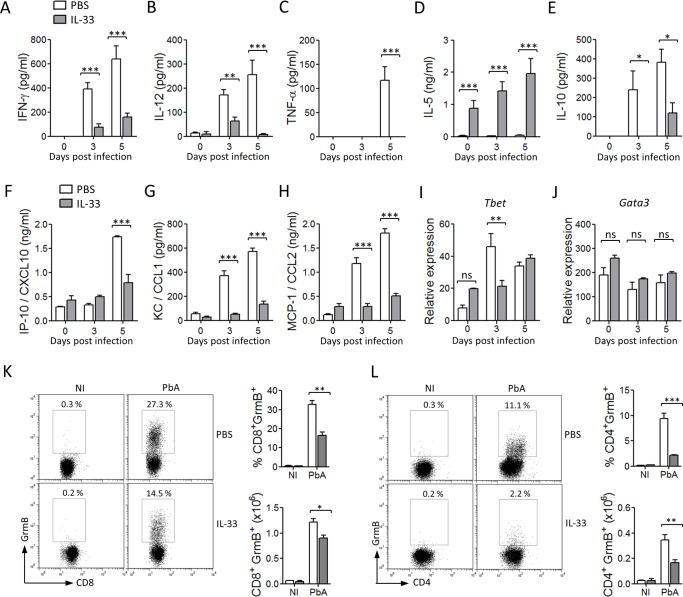
IL-33 reduces pro-inflammatory cytokines and chemokines in PbA-infected mice.C57BL/6 mice were not infected (NI) or infected with PbA and injected i.p. daily with PBS (open columns) or IL-33 (filled columns) from day 0 for 5 consecutive days. (A-H) Serum IFN-γ, IL-12, TNF-α, IL-5, IL-10, IP-10, KC and MCP-1 concentrations were determined by ELISA or Multiplex. Mean ± SEM (n = 5–7 per group). (I-J) Expression of Tbet and Gata3 mRNA (relative to Hprt1) in purified splenic CD4+ T cells was analysed by qPCR (n = 3 per group). Intracellular staining of Granzyme B (GrmB) in splenic CD8+ (K) and CD4+ (L) T cells on day 6. Data are mean ± SEM (n = 5–7 per group). ns, not significant, *P<0.05, **P<0.01, ***P<0.001 by two-tailed ANOVA.